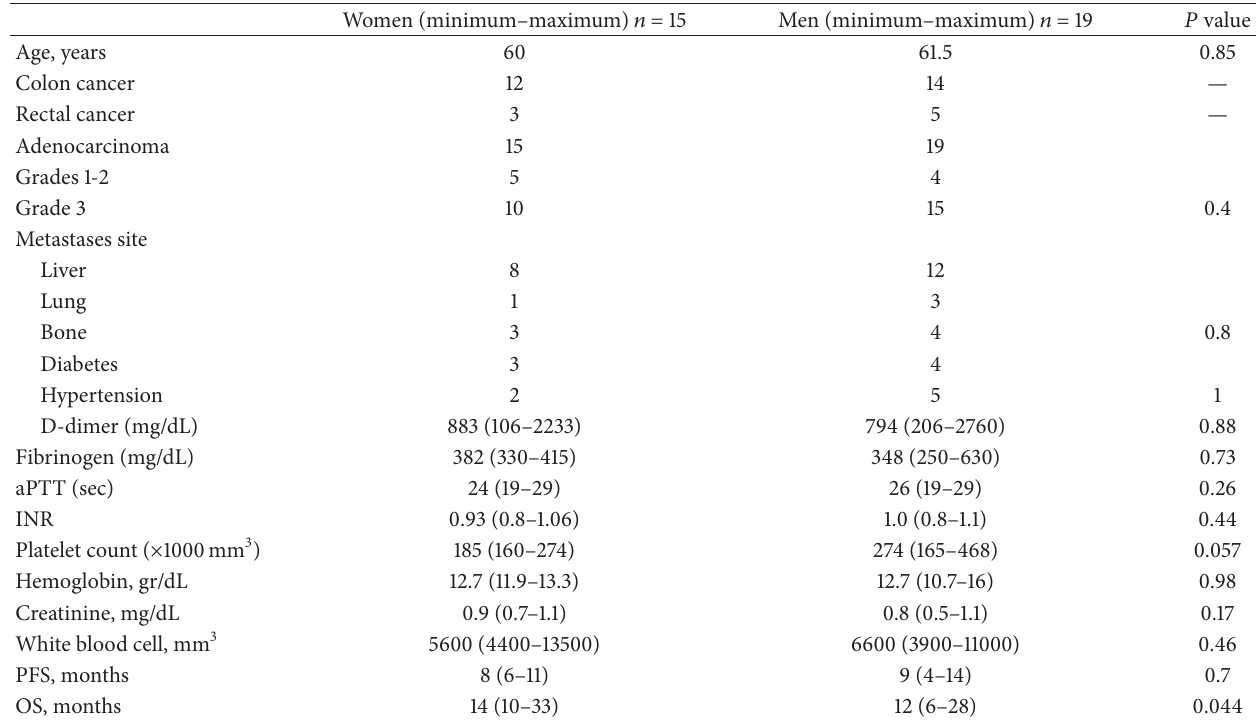
Table 1: Baseline characteristics of the groups.